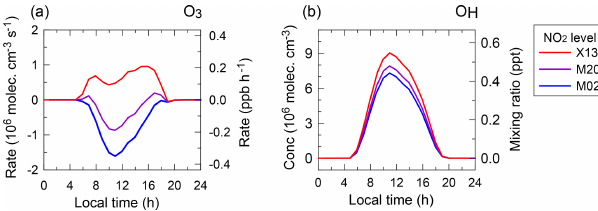
Figure 9. (a) Simulated daily variations in the net ozone production rates and (b) in the OH concentrations and mixing ratios for the free-tropospheric conditions over WLG in summer at different NO 2